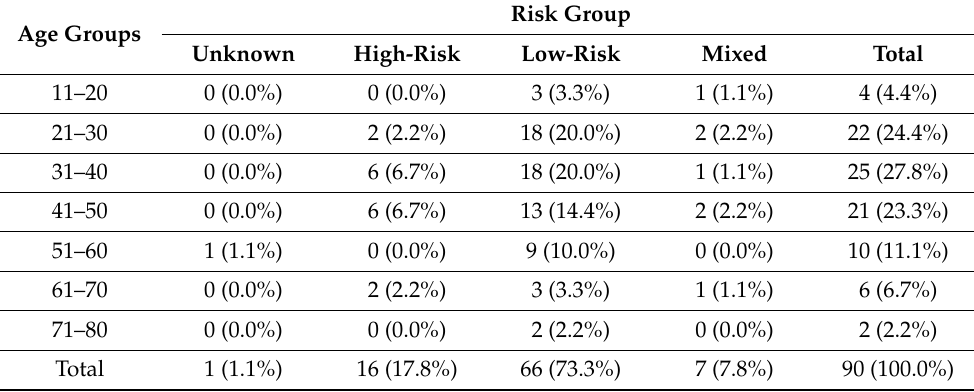
Table 2. High and Low-risk HPV risk in relation to different age